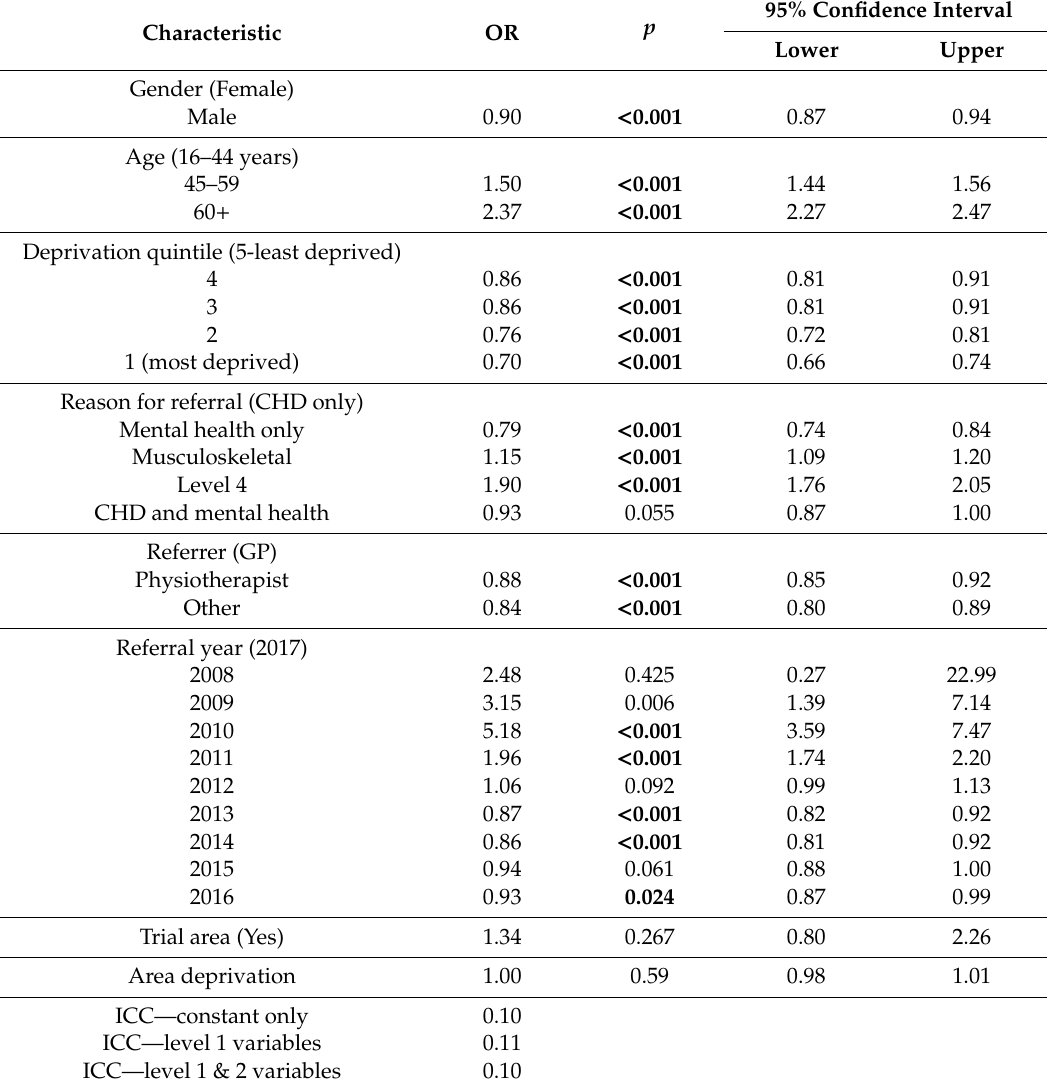
Table 3. Multilevel logistic regression outputs of correlates to scheme uptake ( N = 69,291).